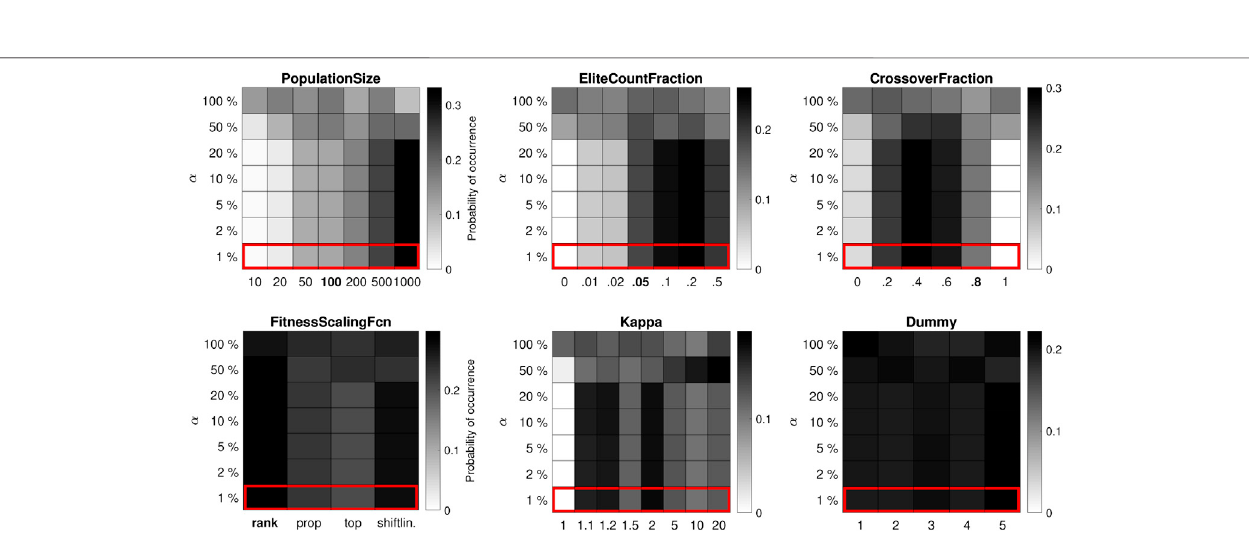
FIGURE3| Distributionofcontrolparametervaluesforthe10-bartrusstestproblem,whereeachrunofthealgorithmhasahighbudgetof10 6 functionevaluations. Apart from a few extremes, the effect of the control parameter values is less important.